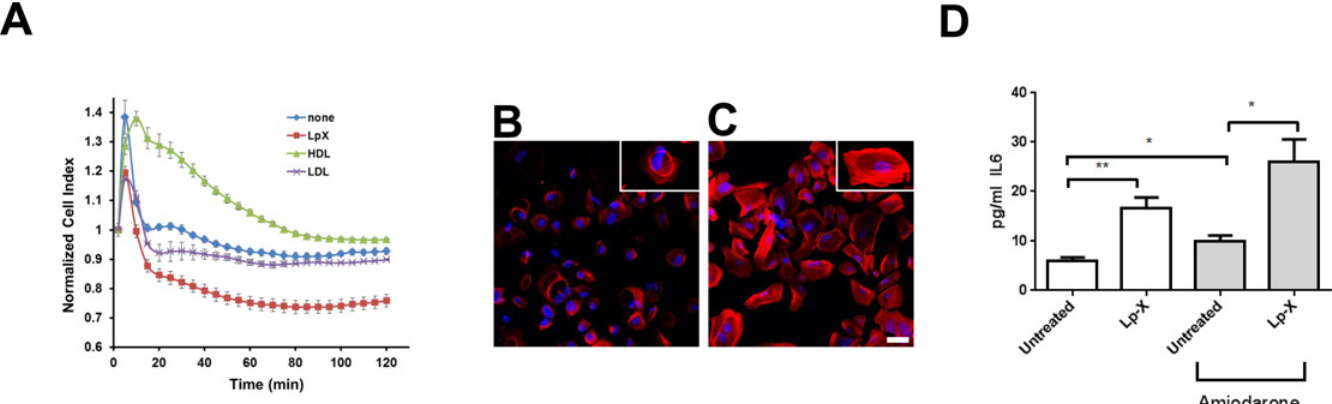
Fig 7. Effect of LpX on glomerular cell function in vitro . (A) LpX compromises the integrity of endothelial cell monolayers. Confluent HUVEC cell monolayers were incubated with PBS alone, or with PBS containing HDL (1 mg/ml), LDL (1 mg/ml), or LpX 5 mg/ml). Following a transient artifactual increase in impedance after the change in medium, LpX markedly decreased impedance. (B,C) LpX alters podocyte cytoskeletal actin organization. Representative confocal images of phalloidin-stained immortalized human podocytes incubated in vitro in the absence (B) or presence of (C) synthetic LpX. Scale bar: 100 μ m.(D) LpX endocytosis stimulates mesangial cell IL-6 cytokine secretion in vitro. Confluent cultured mesangial cells were treated with 200 μ g/ml fluorescent PE-tagged synthetic LpX, in the absence or presence of 5 μ M amiodarone for 18 hrs, and then IL-6 was quantified by ELISA assay. Note that amiodarone further increased IL-6 secretion with or without LpX treatment. * p < 0.05; ** p = 0.01; unpaired two-tailed